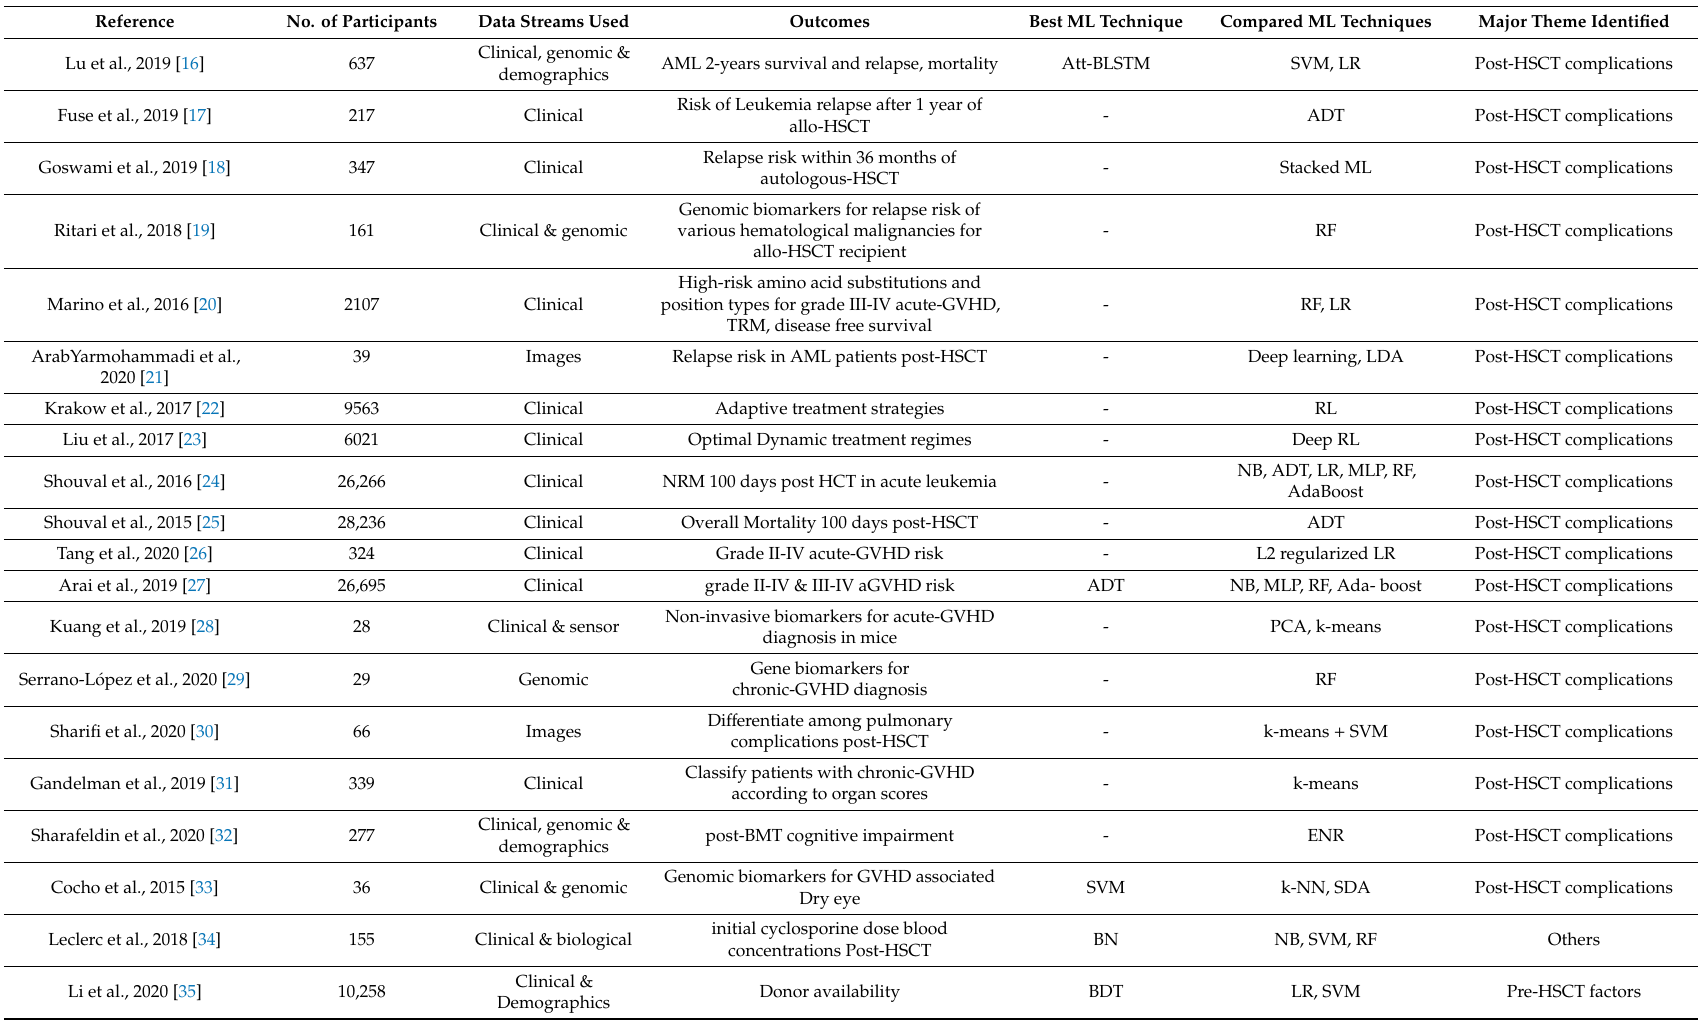
Table 2. A brief summary of reviewed